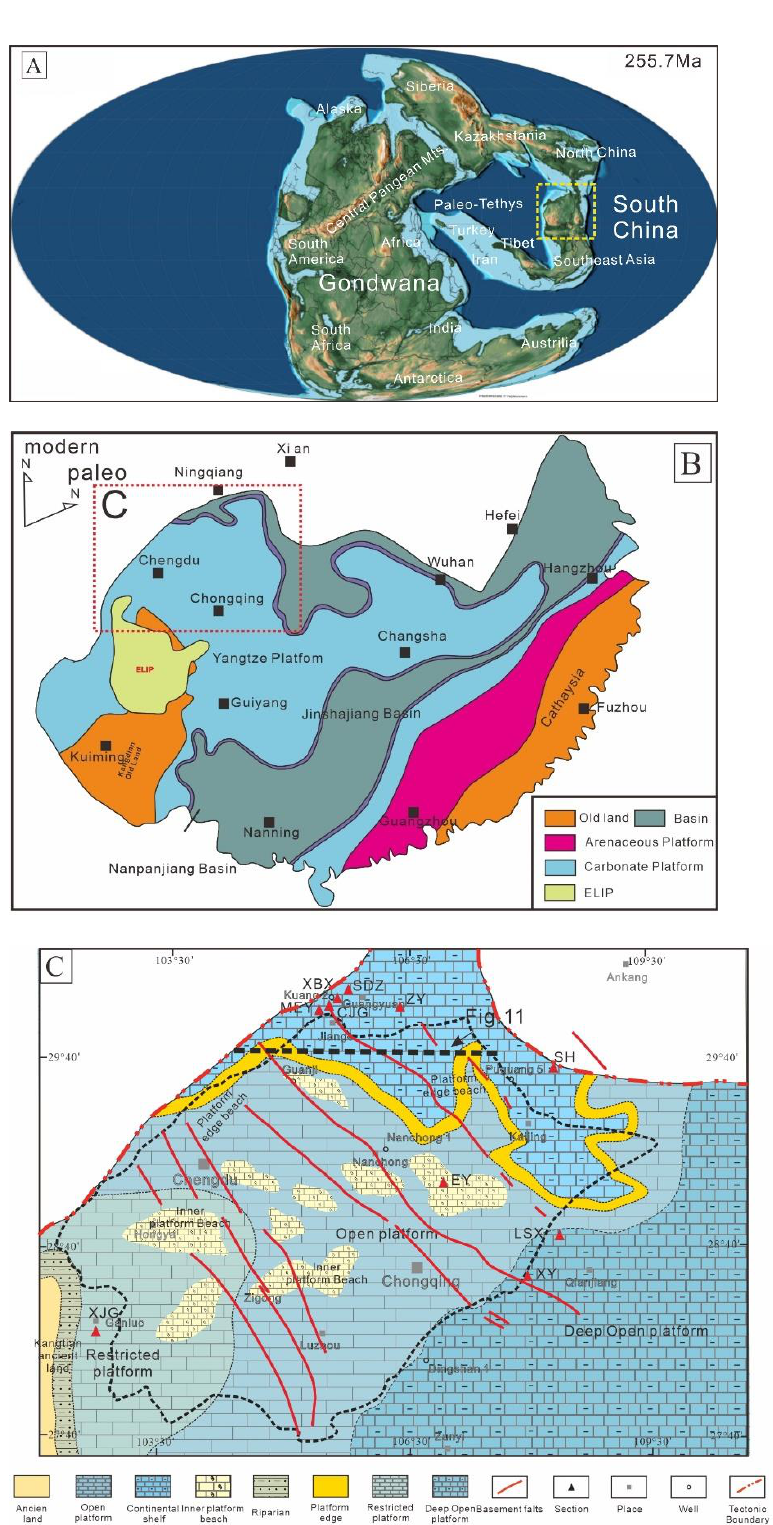
Figure 1. ( A ) Middle Permian (~255.7 Ma) global paleogeography and the location of Sichuan Basin, South China [34] . ( B ) Middle Permian paleogeography of the Upper Yangtze Block [22,35,36] and the location of the Sichuan Basin. ( C ) Maokou paleogeography of Sichuan Basin (basement faults from [37] ). XY: Xiaoyan, EY: Erya, SH: Shuanghe, XBX: Xibeixiang, SDZ: Sanduizhen, ZY: Zhengyuan, LSX: Lengshuixi, XJG: Xinjigu; MEY: Maeryan.